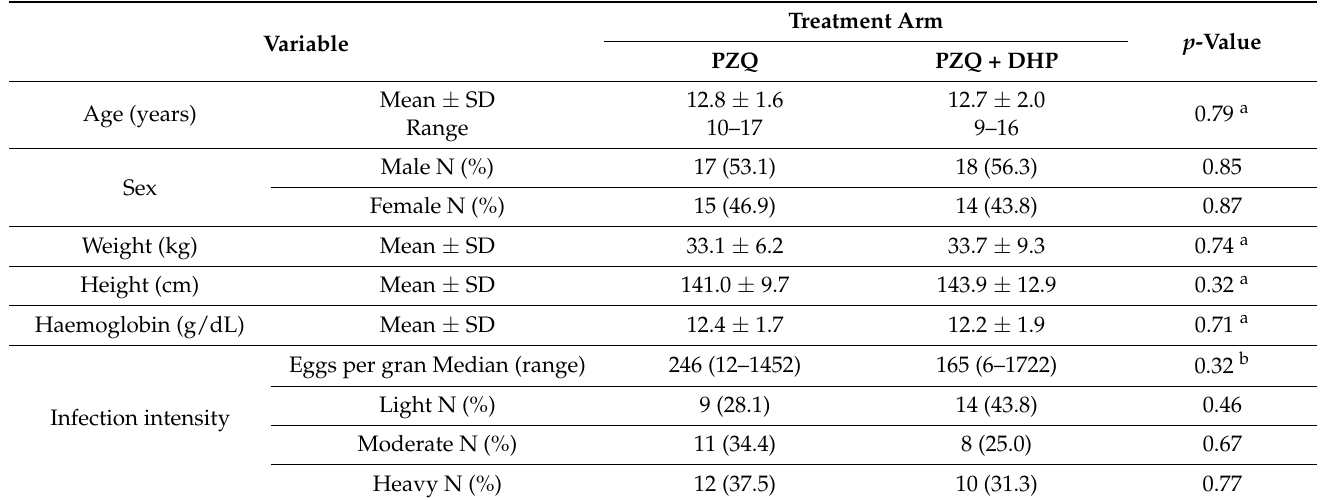
Table 1. Sociodemographic and baseline characteristics of study participants.